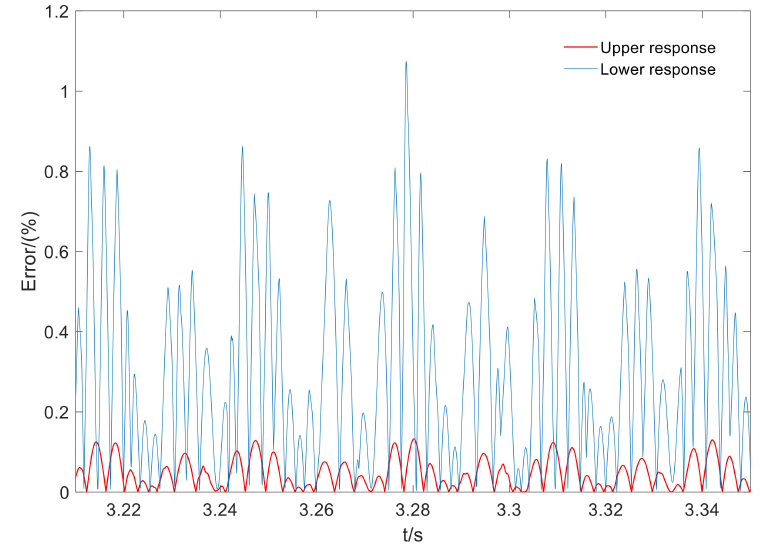
Figure 10. Error diagram for the case with 5% bounded contact sti ff ness uncertainty.